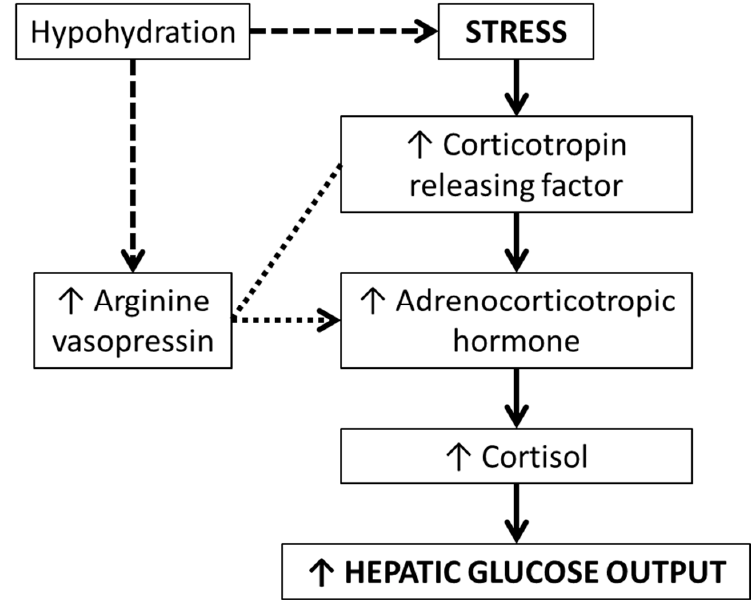
Figure 2. Theoretical relationship between hydration status, arginine vasopressin, and the hypothalamic-pituitary-adrenal axis. Dashed lines represent a mediating relationship (i.e., hydration status directly influences arginine vasopressin, and hydration status may influence stress); dotted lines represent a moderating relationship (i.e., arginine vasopressin determines the propensity of corticotropin releasing factor to be cleaved into adrenocorticotropic hormone)